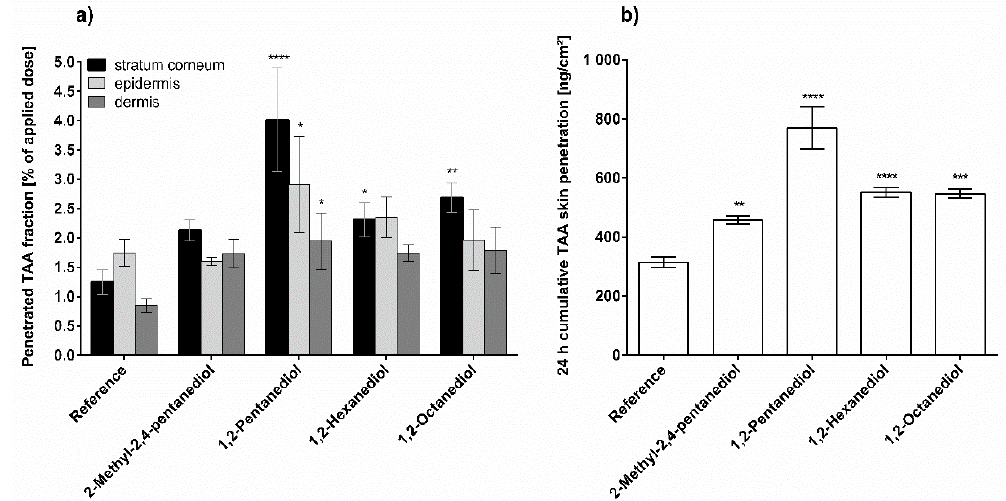
Figure 3. Triamcinolone acetonide penetration from pure anionic hydrophilic cream (reference) and anionic hydrophilic cream with 5% alkanediol after 24 h incubation; ( a ) Penetrated fraction in stratum corneum, viable epidermis and dermis; ( b ) Cumulative skin penetration of triamcinolone acetonide, n = 3, mean ± SD, * p ≤ 0.05; ** p ≤ 0.01; *** p ≤ 0.001; **** p ≤ 0.0001.